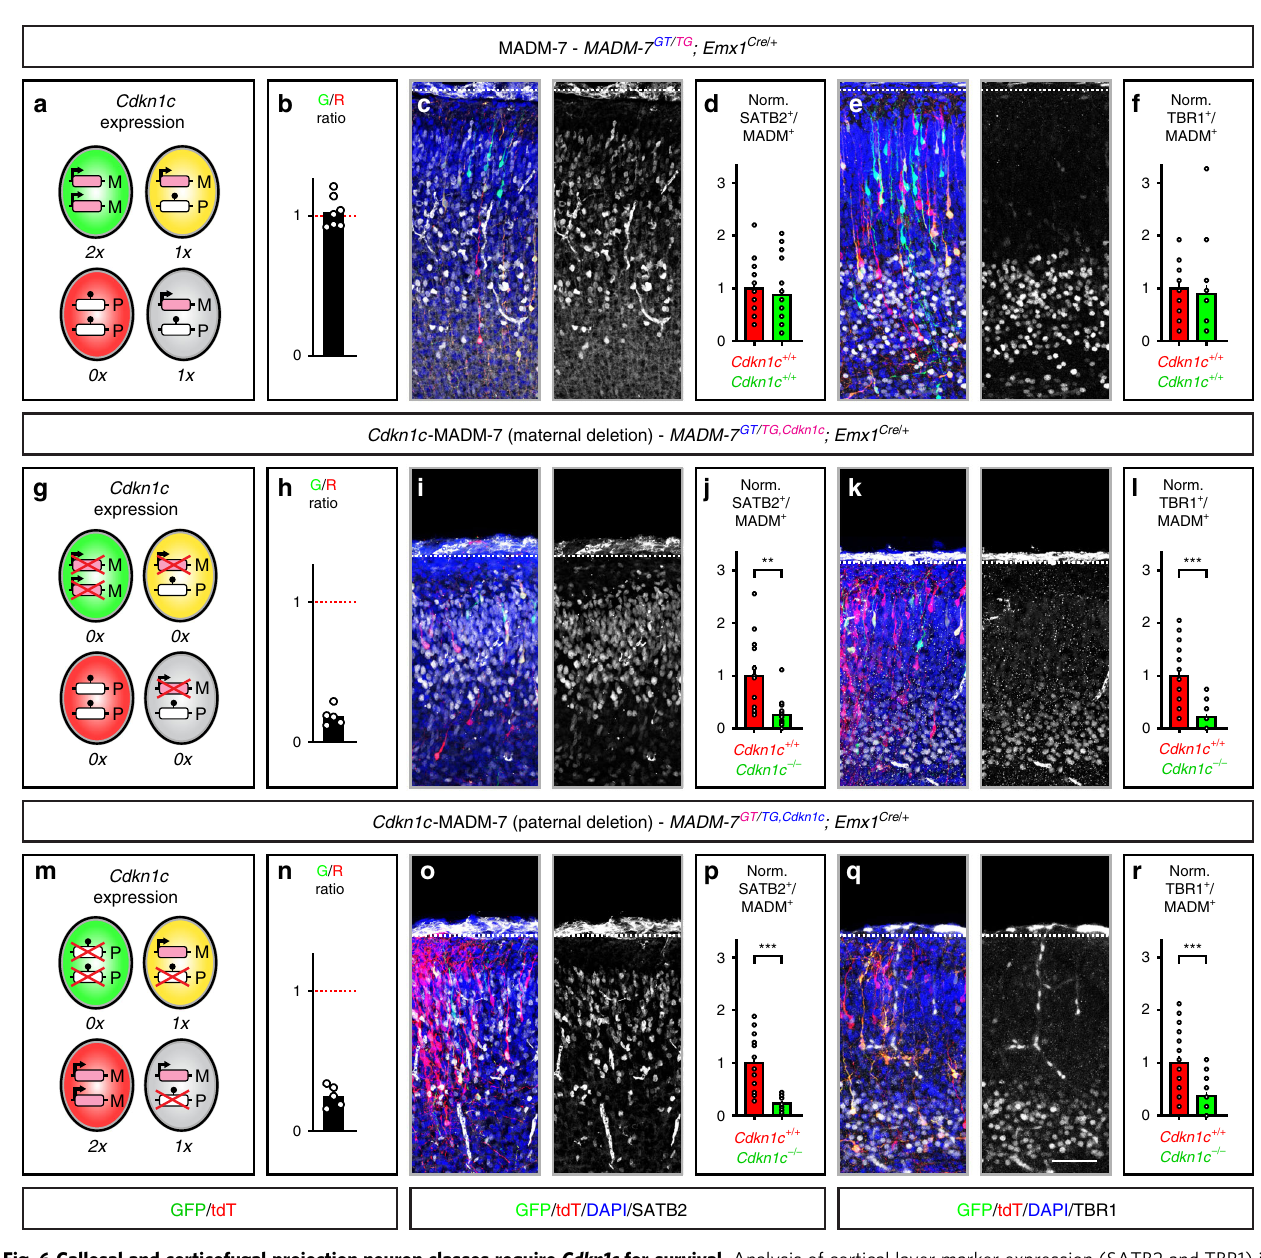
Fig. 6 Callosal and corticofugal projection neuron classes require Cdkn1c for survival. Analysis of cortical layer marker expression (SATB2 and TBR1) in MADM-7 ( MADM-7 GT/TG ;Emx1 Cre/ + ) ( a – f ), Cdkn1c -MADM-7 ( MADM-7 GT/TG,Cdkn1c ;Emx1 Cre/ + ) with maternal deletion ( g – l ), and Cdkn1c -MADM-7 ( MADM-7 GT/TG,Cdkn1c ;Emx1 Cre/ + ) with paternal deletion ( m – r ), in cerebral cortex at P0. The parent, from which the MADM cassette and with recombined Cdkn1c- fl ox allele ( Cdkn1c ) was inherited, is indicated in the respective genotypes in pink (mother) and blue (father). Schematics ( a , g , m ) depict green (GFP + ), red (tdT + ), yellow (GFP + /tdT + ) and unlabeled MADM cells with UPD (red, green) and control cells (yellow, unlabeled). Imprinting (arrow, expression; ball on stick, repression) and expression (0×, 1×, 2×) status of Cdkn1c is indicated. Conditional deletion of Cdkn1c is marked with red cross. Parental origin of chromosome is indicated (M maternal, P paternal). G/R ratio ( b , h , n ) of single MADM-labeled cortical neurons is depicted as geometric mean. Data points indicate individual animals ( n = 5 – 7). Labeling of upper layer callosal SATB2 + cells (white) ( c , i , o ) and lower layer corticofugal TBR1 + cells (white) ( e , k , q ) in MADM tissue (GFP + , green; tdT + , red; GFP + /tdT + , yellow); and quanti fi cation of SATB2 + /MADM + ( d , j , p ) and of TBR1 + / MADM + ( f , l , r ) cells. Red cell numbers are centered to 1 and green cell numbers are shown relative to red (** p < 0.01, *** p < 0.001, two-tailed t test). All bars indicate mean. Error bars represent SEM ( d , j , p and f , l , r ). Note the decrease in GFP + mutant double-positive neurons when compared to tdT + wild- type cells. Data points indicate individual animals ( n = 5 – 7) for G/R ratio; and individual sections ( n = 15 – 22) for layer marker expression. Nuclei were stained using DAPI (blue). Scale bar, 50 µ m. Source data are provided as a Source Data fi Single-cell suspension and antibody-based FACS . Single-cell suspension was performed according to a protocol described previously 23 . The following antibodies prepared using Neural Tissue Dissociation Kit (Miltenyi #130-092-628) following were used for FACS: Prominin-1-PEVio770 1:100 (Miltenyi, Clone: MB9-3G8, the manufacturer ’ s instructions. Pregnant females were sacri fi ced by cervical dis- location. E12 embryos were isolated and directly transferred into 1× PBS and kept on ice. Region of interest (neocortex) was dissected and used for single-cell sus- pension preparation. Enrichment for neurons and RGPs (progenitors) was